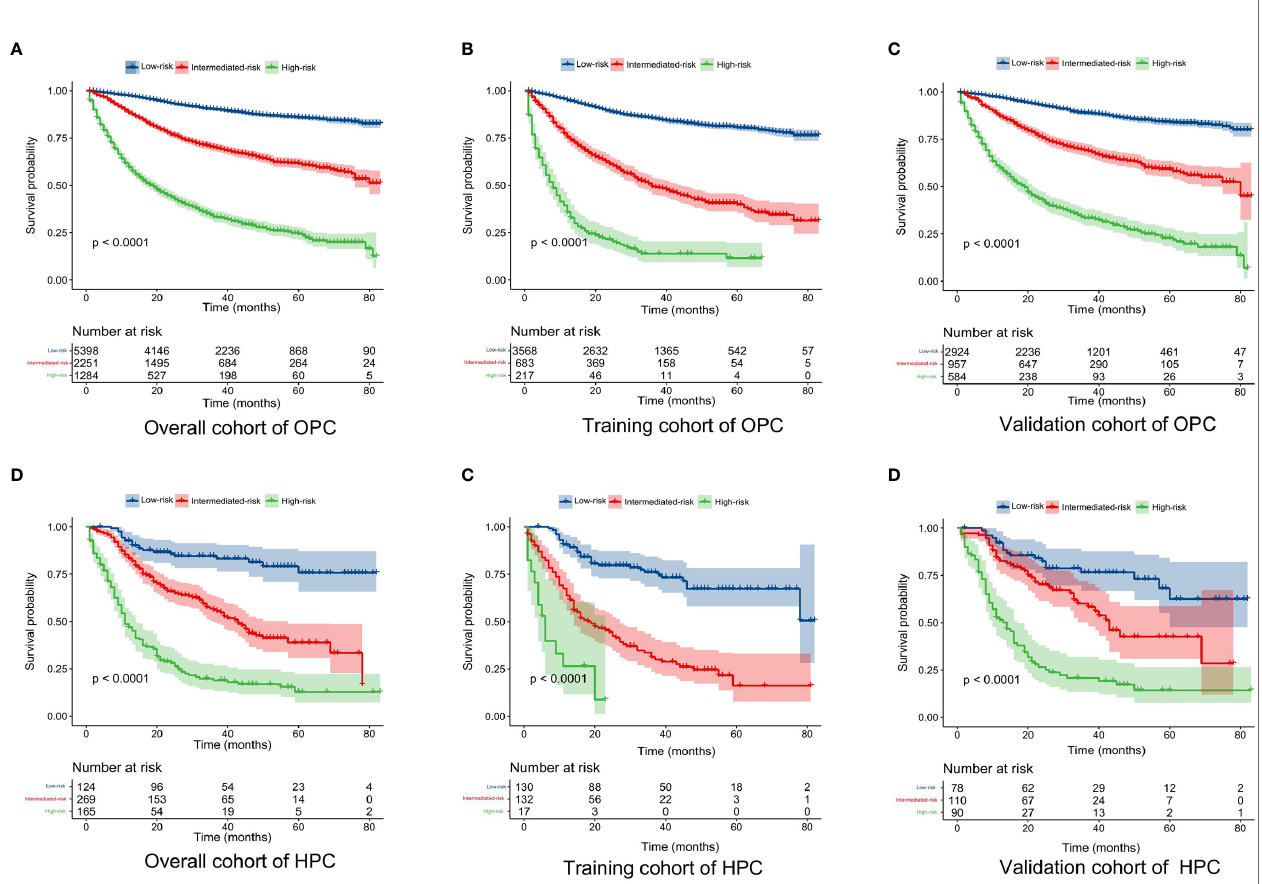
FIGURE 6 | Kaplan – Meier curves of the OS for OPC and HPC patients in the low-, intermediate-, and high-risk groups. (A – C) : Kaplan – Meier curves of the OS for OPC patients in the overall, training, and validation cohort; (D – F) Kaplan – Meier curves of the OS for HPC patients in the overall, training, and validation cohort. OS, overall survival; OPC, oropharyngeal carcinoma; HPC, hypopharyngeal